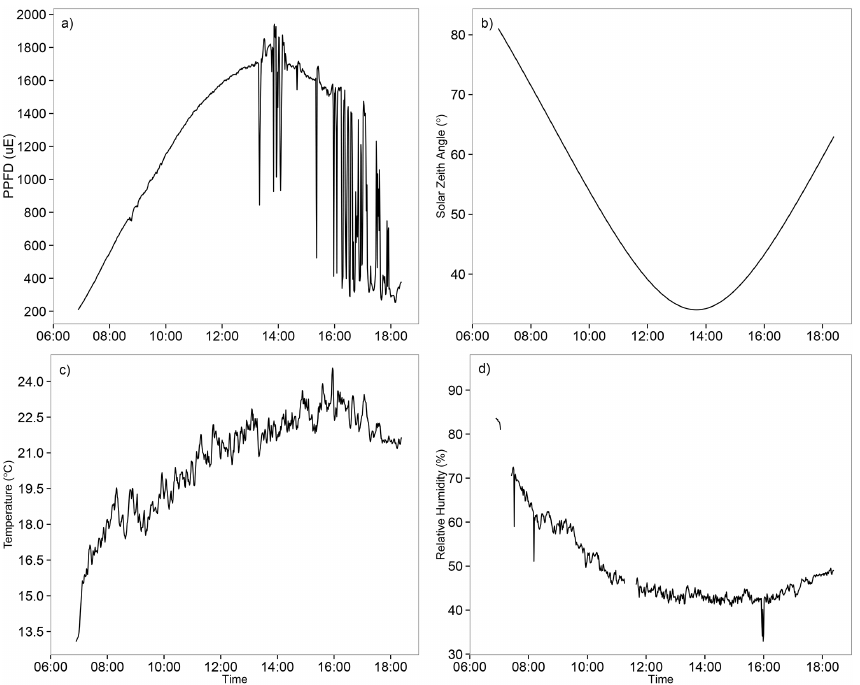
Figure 6. (a) Photosynthetic photon flux density (PPFD), (b) solar zenith angle (SZA), (c) temperature and (d) relative humidity as a function of time of day (July 25,